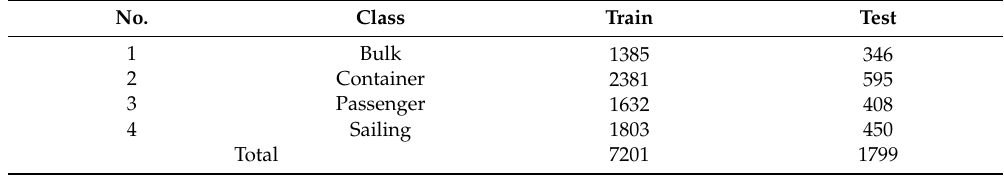
Table 5. Original images test dataset .